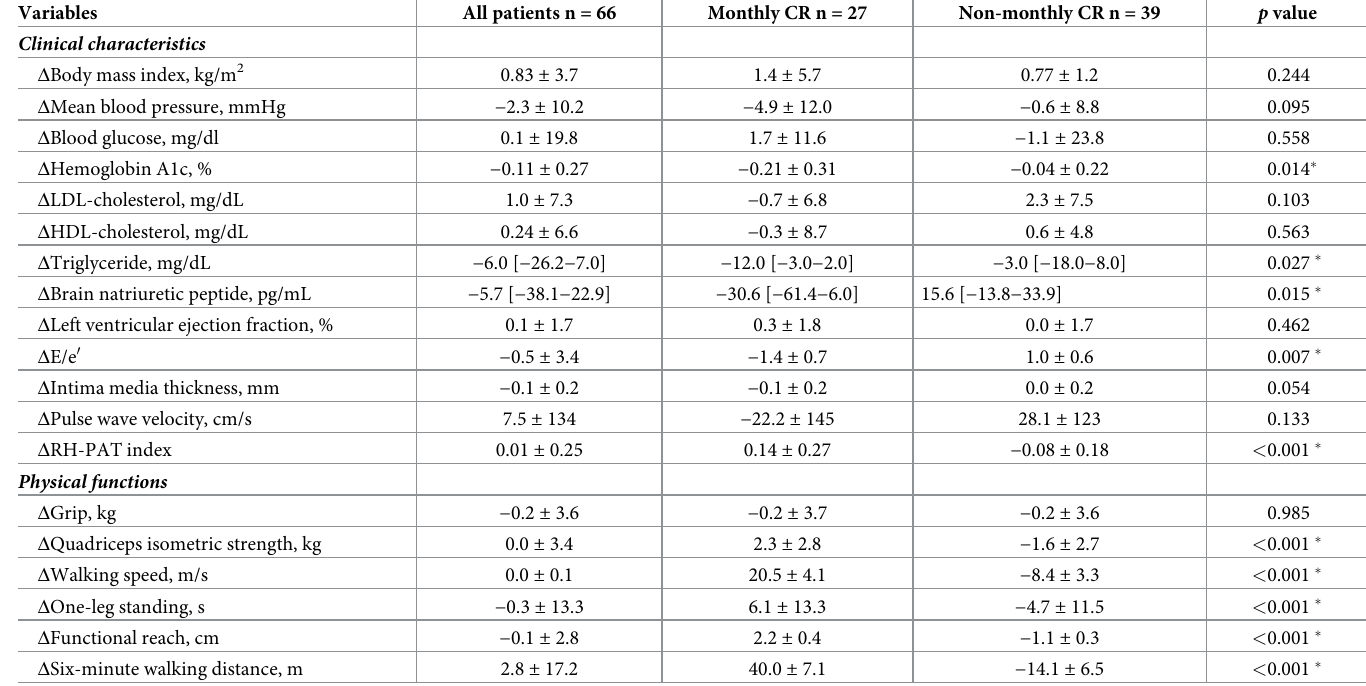
Table 2. Changes in laboratory findings and physical function.